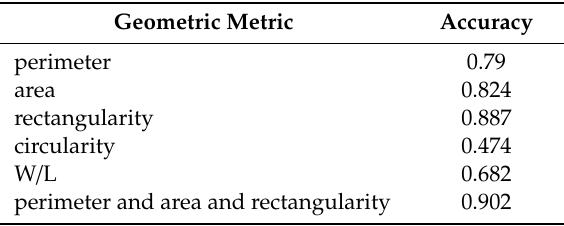
Table 2. The results of different geometric metrics.